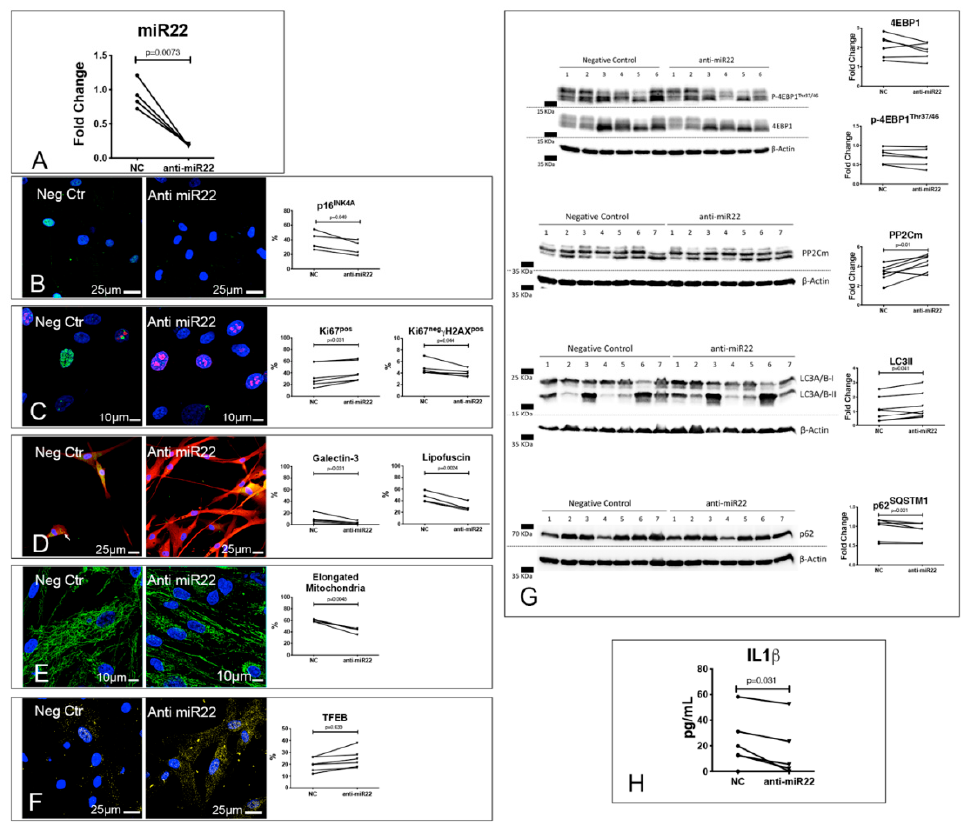
Figure 6. Inhibition of miR-22 reverses E DCM -CPc senescence. Results of RT-PCR analysis of E DCM -CPc treated with either anti-miR22 or a negative control (NC; ( A )). ( B – F ) Reversal of E DCM -CPc senescence and ALP dysfunction by miR-22 inhibition. Confocal images of E DCM -CPc treated with either anti-miR22 or NC showing positivity to p16INK4A (green, ( B )), γ H2A.X (green) and Ki67 (red, ( C )), lipofuscins (green) and Galectin 3 (red, D ), mitochondria (green, ( E) ), and TFEB (yellow, ( F )). Nuclei are labeled by DAPI in blue. ( G ) E ff ects of miR-22 inhibition on mTOR targets, PP2Cm, and autophagy. Representative WB of whole protein extracts of 6–7 E DCM -CPc treated with either anti-miR22 or NC ( G ). Blotted proteins were incubated with antibodies against 4EBP1, p-4EBP1 Thr37 / 46 , PP2Cm, LC3A / B or p62 SQSTM1 . Results of the quantitative analyses are reported in the right panels. (H) E ff ects of miR-22 inhibition on IL1 β secretion. ELISA assay was used for the detection of IL1 β released in the culture supernatant of 7 E DCM -CPc treated with either anti-miR22 or NC ( H ). Dot plots indicate the results of quantitative analyses; paired t tests (p16 INK4A , Ki67, lipofuscin, mitochondria, TFEB, 4EBP1, p-4EBP1 Thr37 / 46 , PP2Cm, and LC3A / B) or Wilcoxon tests (Ki67 − γ H2A.X + , Galectin 3, p62 SQSTM1 , and IL1 β ) were employed, as appropriate.